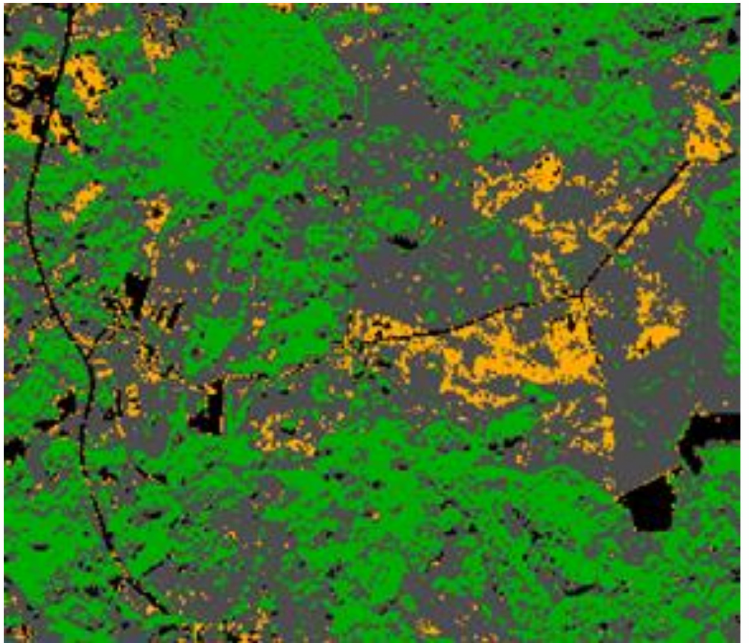
Figure 3. Image pixels classified by the support vector machine (SVM) method (minimum distance algorithm): H. sosnowskyi —yellow; forest—green; pathways—black (Source: authors).